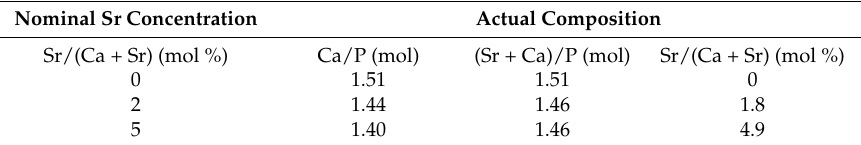
Table 1. ICP analysis of the as-obtained Sr- α TCP precursors and final cements.